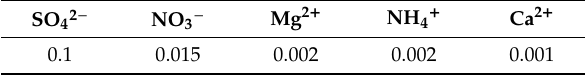
Table 2. Chemical composition ( M ) of the simulated acid rain.